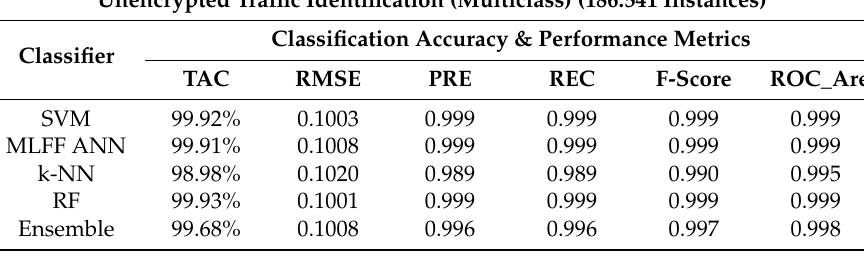
Table 5. Comparison between